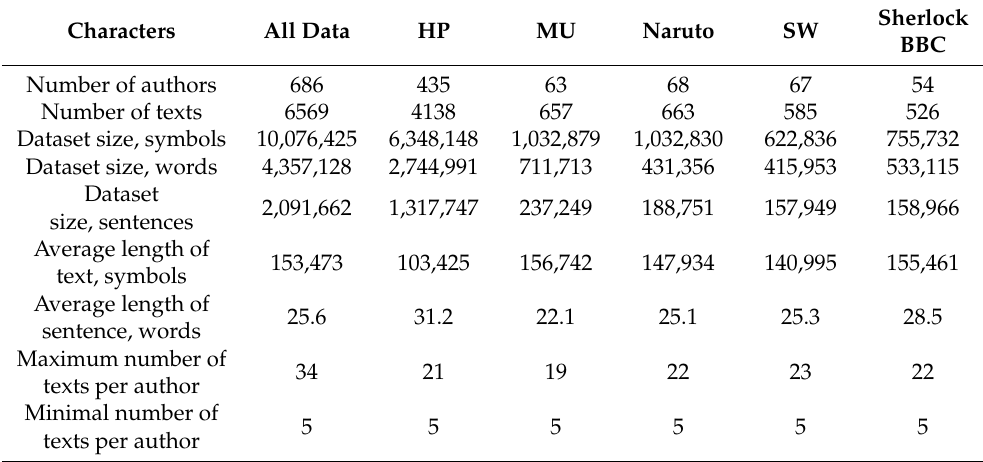
Table 2. Information about the fanfiction